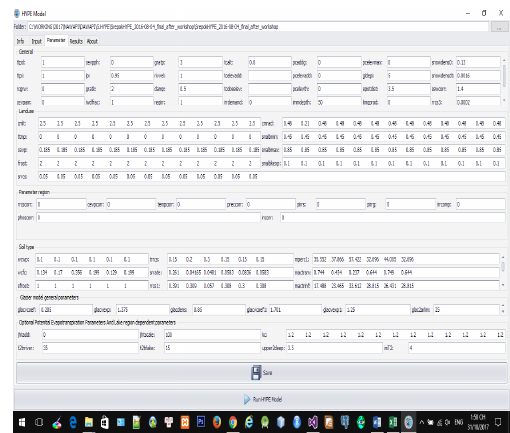
Fig. 8: Function of parameters update for HYPE model.